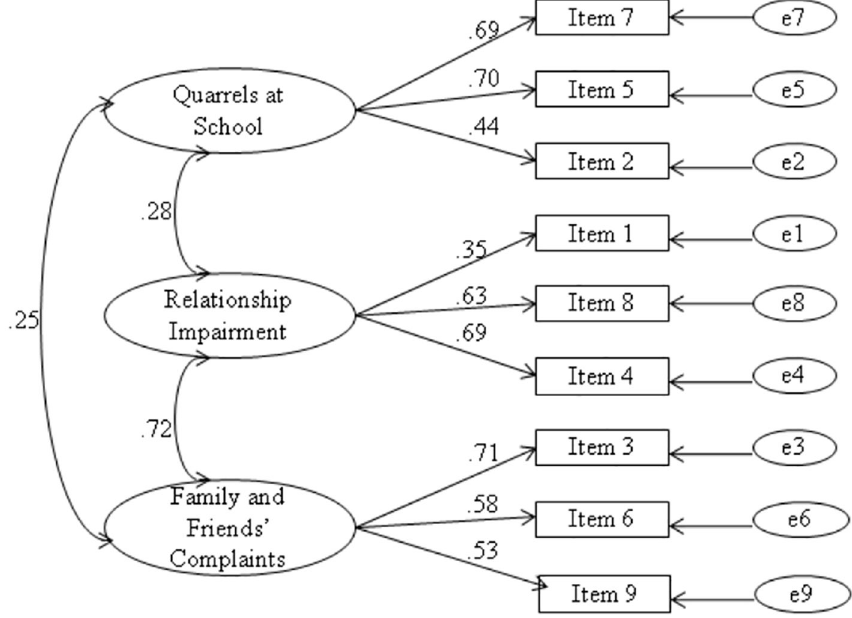
Figure 1. Three-Factor Model, Study-Relationships Conflict Scale, n = 308. Note. The correlations between errors are not